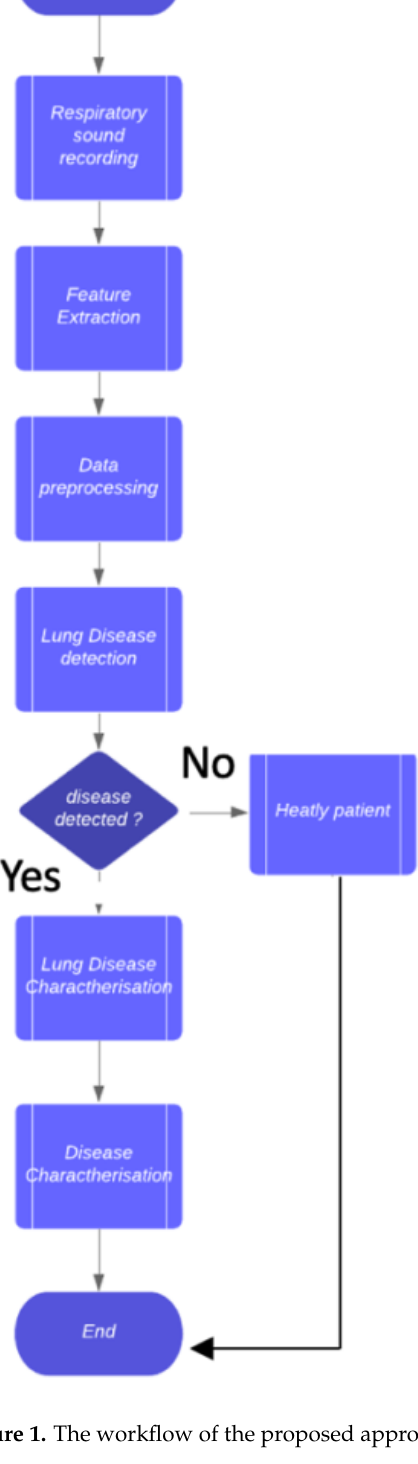
Figure 1. The workflow of the proposed approach for lung disease